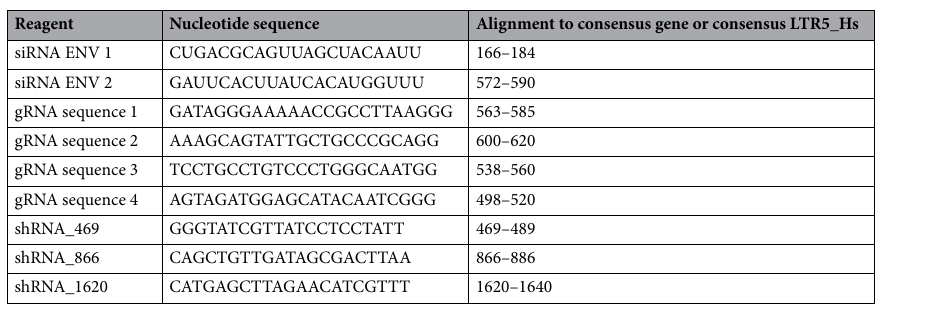
Table 1. Sequences of siRNA, shRNA, and gRNAs targeting HML-2 expression.